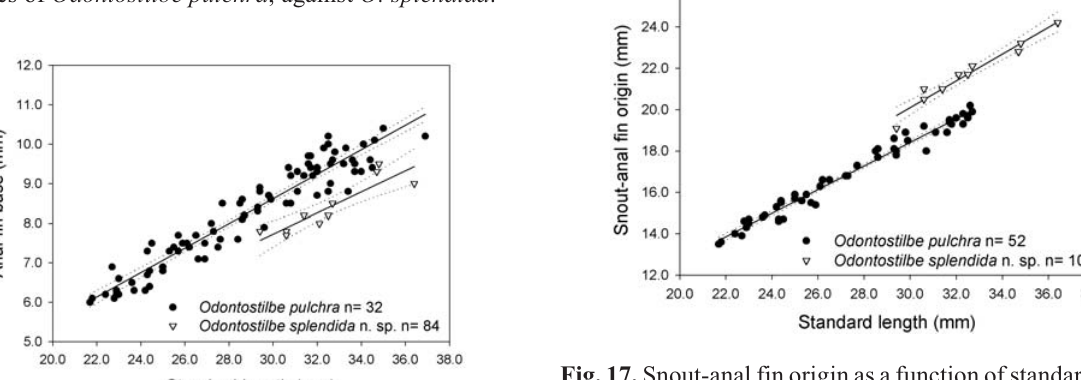
Fig. 13. Pectoral-fin length as a function of standard length for males of Odontostilbe pulchra , against O. splendida .